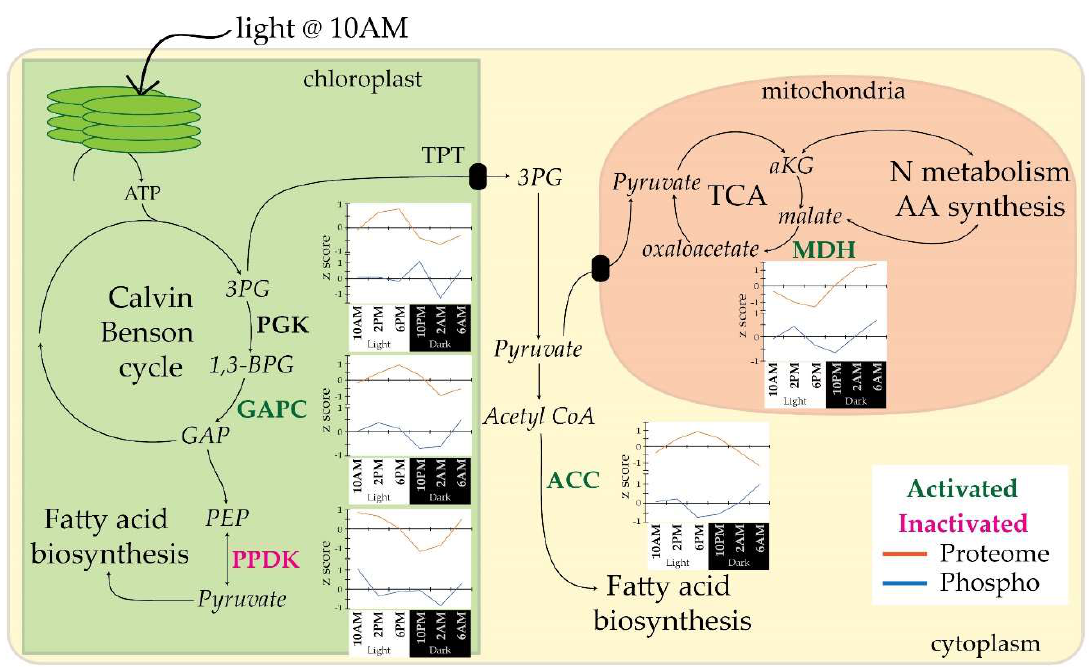
Figure 3. Phosphorylation of carbon metabolism gene products suggests a role for phospho-regulation in directing carbon into fatty acid biosynthesis. Phosphoproteins were identified to be inactivated at 6 AM but reactivated at 10 AM (green, bold), inactivated at both 6 AM and 10 AM (pink, bold) or undetermined (black, bold). Diel profiles normalized across the time course (z score) indicate phospho-regulation as the change in phosphorylation (blue line) is not proportional to the change in total protein abundance (orange line) between timepoints. Chloroplast phosphoglycerate kinase (PGK; Phatr3_J29157); chloroplast glyceraldehyde 3-phosphate dehydrogenase (GAPC; Phatr3_J22122); chloroplast pyruvate orthophosphate dikinase (PPDK; Phatr3_J21988); cytoplasmic acetyl-CoA carboxylase (ACC; Phatr3_J55209), mitochondrial NAD-dependent malate dehydrogenase (MDH; Phatr3_J42398). Refer to Table S7 for a summary of the possible effect of phosphorylation on these phosphoproteins.